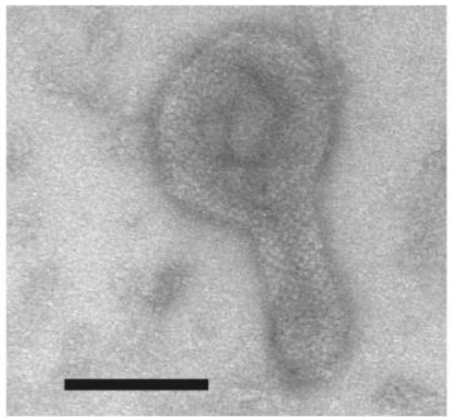
Figure 4. The SR vesicle with a crystal-array of surface particles, observed in the presence of 5 mM ATP at 25 ◦ C. The SR preparation (0.3 mg of protein/mL) was incubated with 5 mM ATP for 1 min under the conditions of 0.04 nM Ca 2+ at pH 7.4 and 25 ◦ C. Scale bar: 100